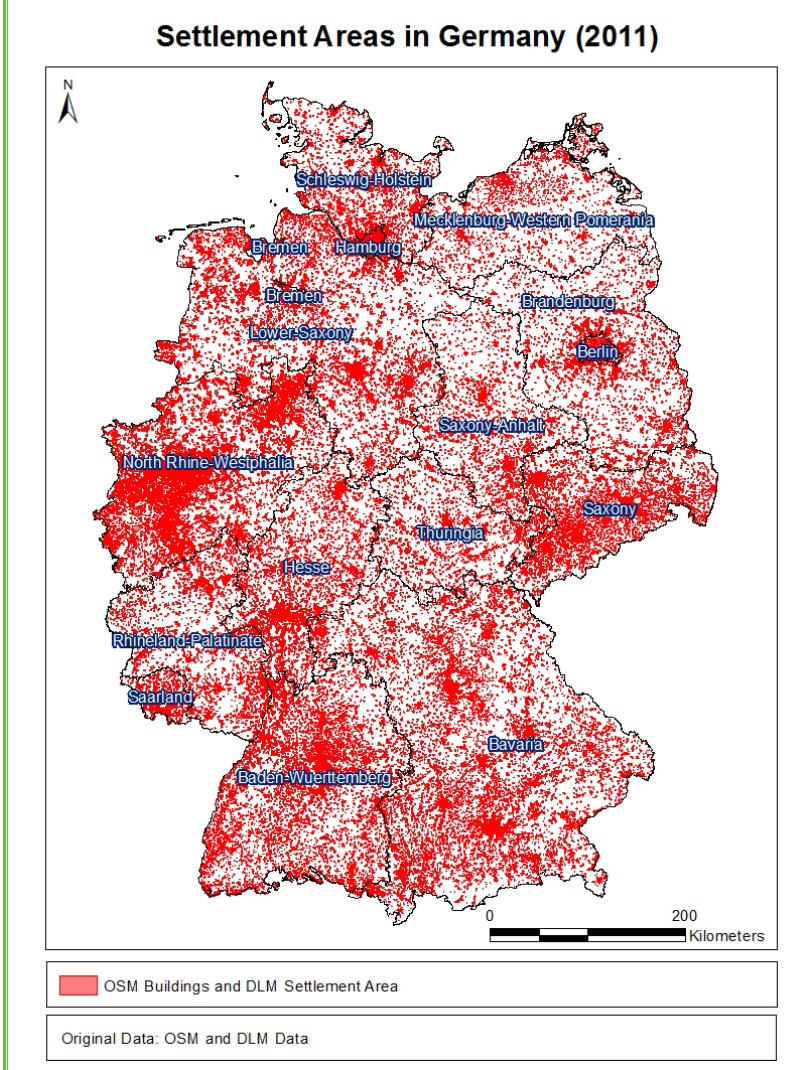
Figure 6. Settlement areas in Germany in 2011 (DLM &